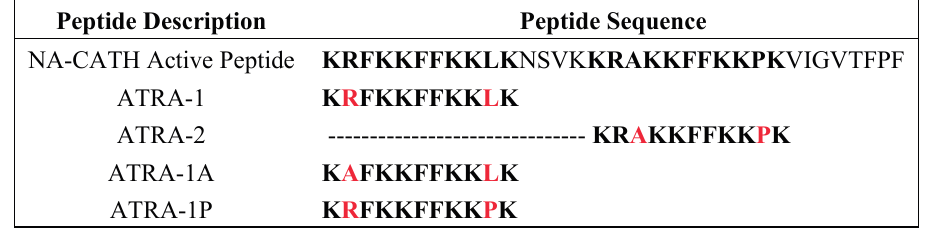
Figure 7. Naja atra cathelicidin peptide analysis. ( a ) Sequences of the NA-CATH active peptide and derivatives [102–105]. ( b ) Helical wheel projection of NA-CATH. ( c ) Analysis of the active ATRA-1A peptide ( d ) Analysis of the inactive ATRA-1P peptide. From Rzlab.ucr.edu/scripts/wheel/wheel.cgi: “The hydrophilic residues are presented as circles, hydrophobic residues as diamonds, potentially negatively charged as triangles, and potentially positively charged as pentagons. Hydrophobicity is color coded as well: the most hydrophobic residue is green, and the amount of green is decreasing proportionally to the hydrophobicity, with zero hydrophobicity coded as yellow. Hydrophilic residues are coded red with pure red being the most hydrophilic (uncharged) residue, and the amount of red decreasing proportionally to the hydrophilicity. The potentially charged residues are light